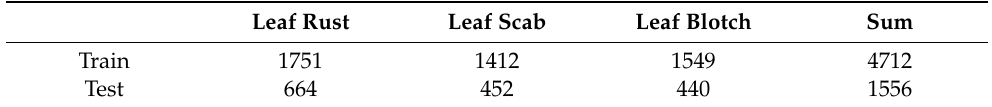
Table 1. Label distribution of